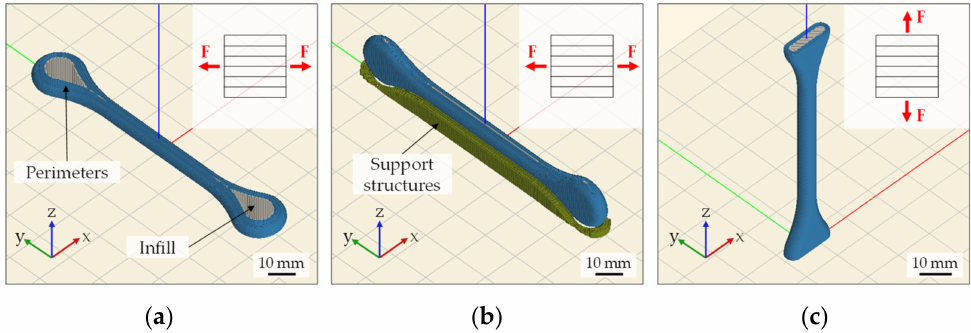
Figure 9. Representation of tensile specimens in Slic3r: ( a ) flat; ( b ) side; ( c ) vertical.